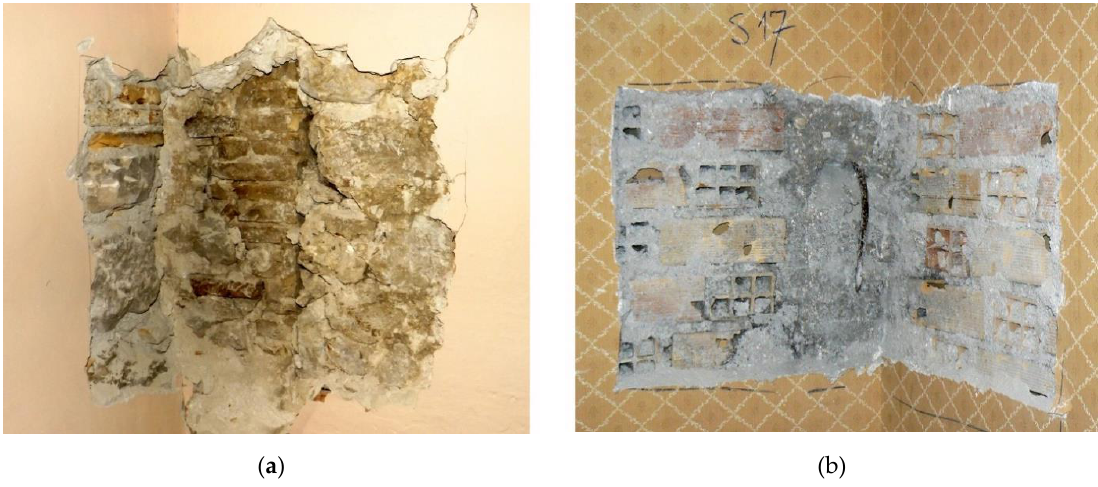
Figure 5. The walls of ( a ) the main body of the castle and ( b ) the tower.